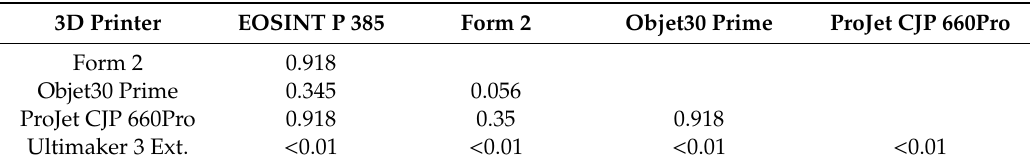
Table 7. p -values of pairwise Wilcoxon rank sum tests. 1